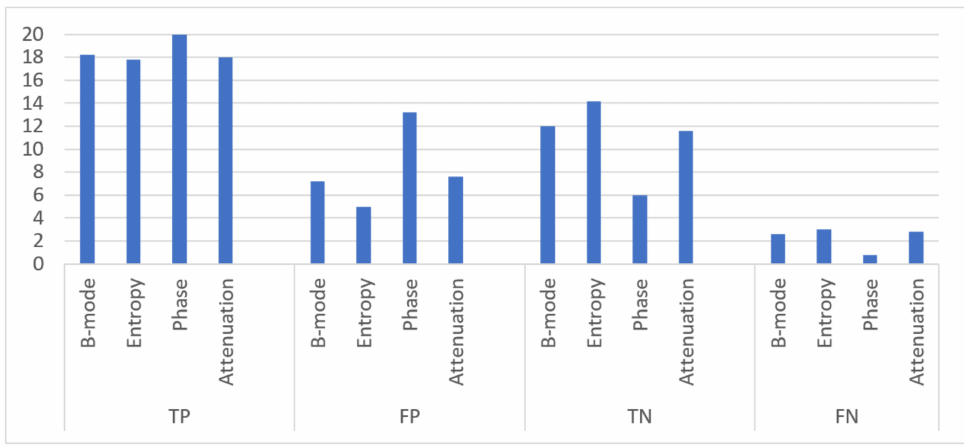
Figure 6. Average classification results of 5-fold experiments using the VGG-16 backbone network for 40 test images.